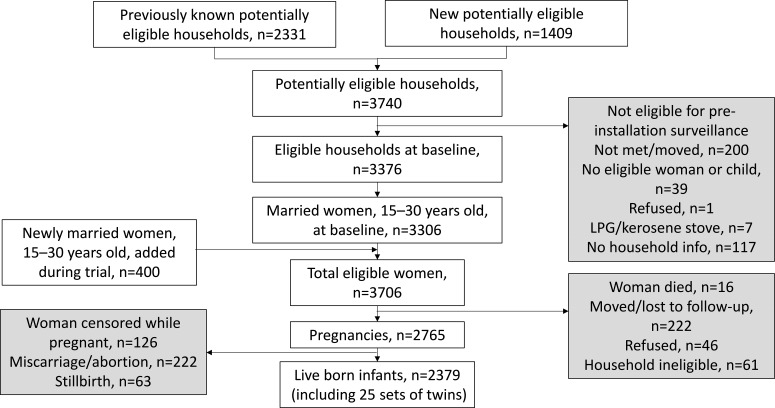
Nepal Cookstove Intervention Trial, Phase 1 CONSORT Diagram